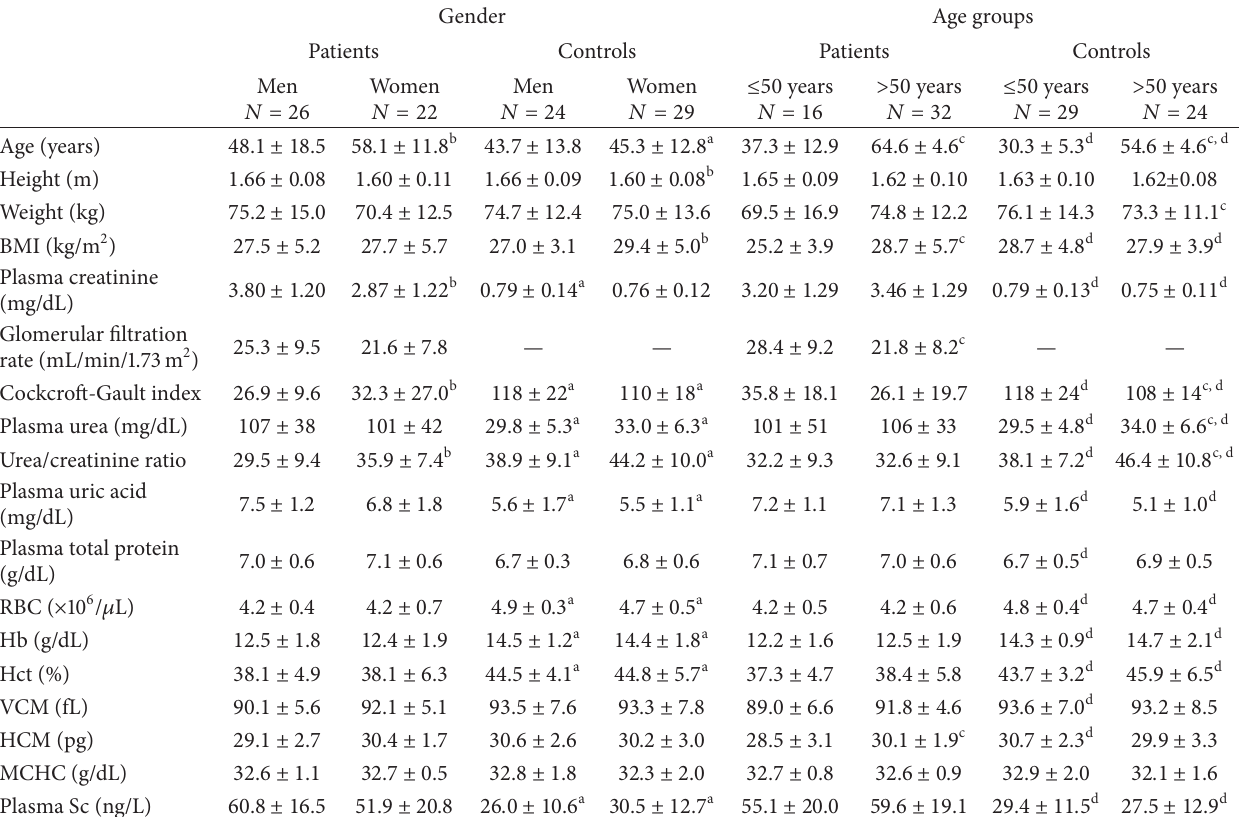
Table 2: Anthropometric, biochemical, and haemogram variables and plasma levels of Sc, by gender and age